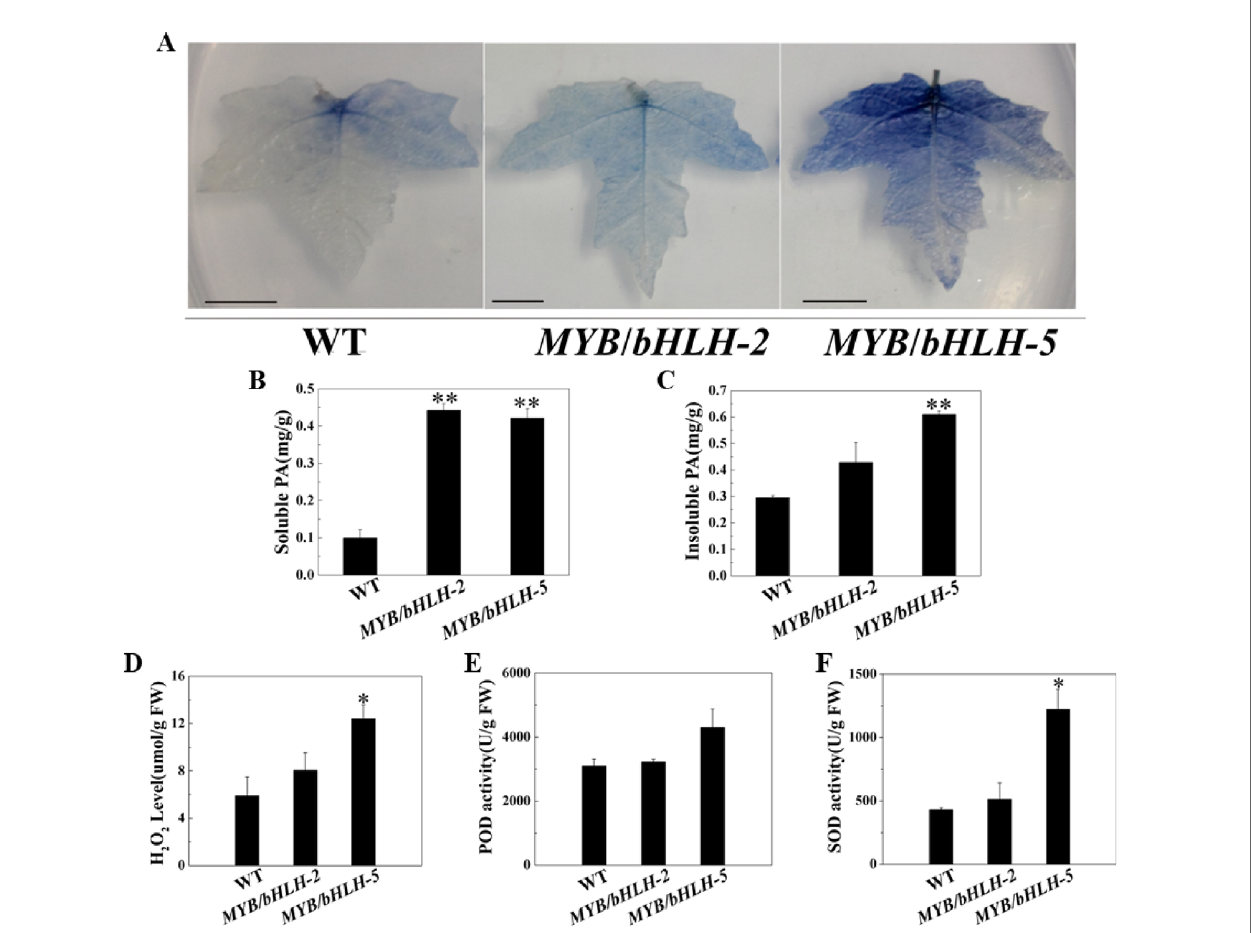
FIGURE 3 | Quanti fi cation of insoluble and soluble tannin (PA) and reactive oxygen species in wild-type (WT) and transgenic lines ( MYB90 / bHLH1 -OE 2 and MYB90 / bHLH1 -OE 5). (A) PA accumulation detected by DMACA staining. (B) Quanti fi cation of soluble PA. (C) Quanti fi cation of insoluble PA. (D) Changes in H 2 O 2 content and (E, F) activities of two antioxidases, POD and SOD, in MYB90 / bHLH1 -OE poplar leaves. Values represent the means of three replications. Error bars indicate ± SE. Asterisks indicate signi fi cant differences: * P < 0.05. Asterisks (**) indicate signi fi cant differences, P ≤